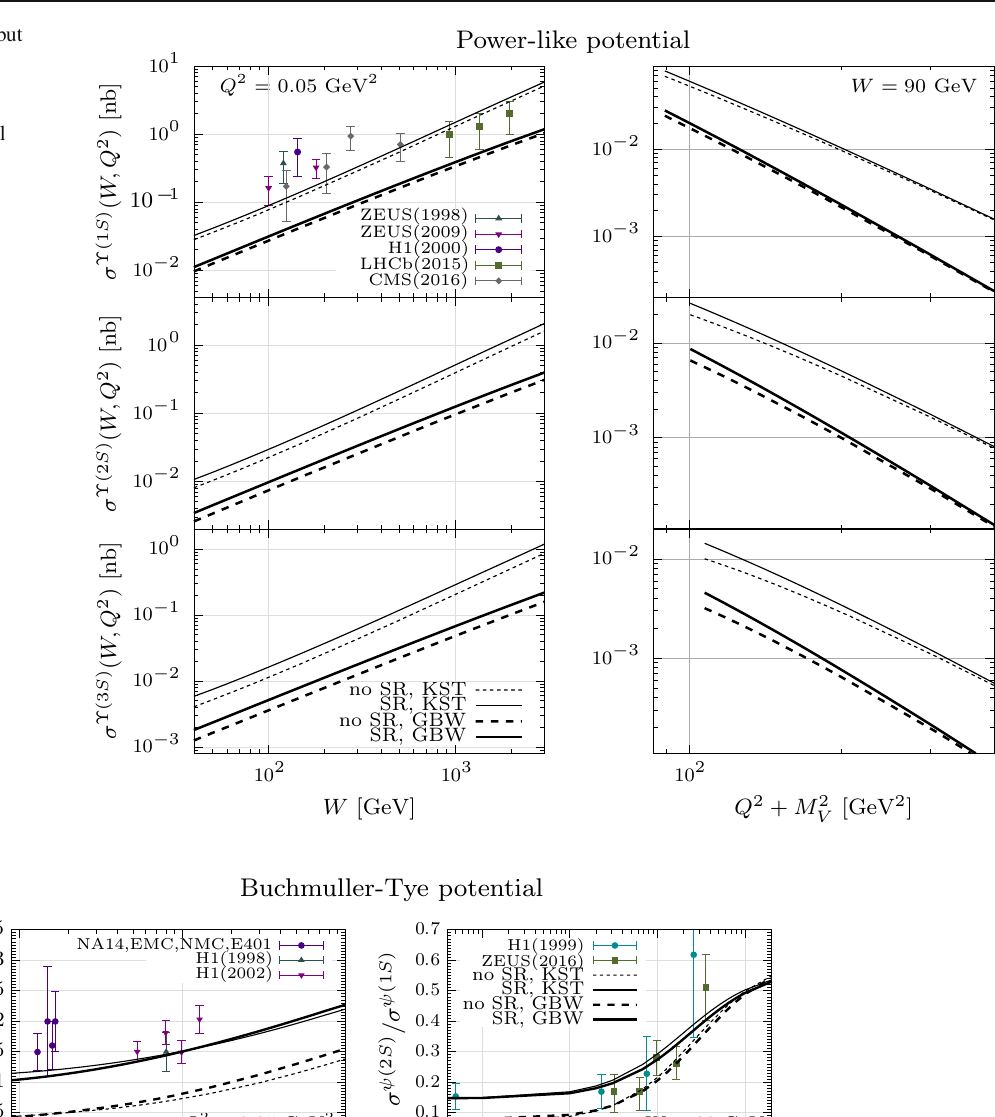
Fig. 7 Predictions for the ratio of ψ (cid:2) ( 2 S ) to J /ψ( 1 S ) photoproduction cross sections as a function of c.m. energy W at fixed Q 2 = 0 . 05 GeV 2 (left box), and as a function of the photon virtuality Q 2 at fixed c.m. energy W = 90 GeV (right box). All model predictions have been performed with the wave functions of J /ψ( 1 S ) and ψ (cid:2) ( 2 S ) using the realistic Buchmüller–Tye potential [31]. The solid and dashed curves